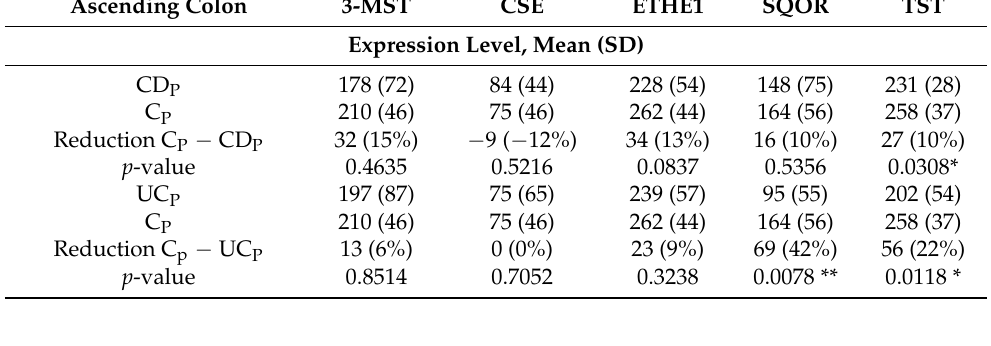
Table 8. Expression as mean with standard deviation (SD), absolute reduction and percentage as well as p -value of the ascending colon in children with Crohn’s disease (CD P ) and children with ulcerative colitis (UC P ) compared to age matched controls (C P ). Pediatric (P); adult (A); cystathionine- γ - lyase (CSE); 3-mercapto-sulfurtransferase (3-MST); ethylmalonic encephalopathy 1 protein (ETHE1); sulfide:quinone oxidoreductase (SQOR) and thiosulfate sulfurtransferase (TST). * = p -value < 0.05, ** = p -value < 0.01.